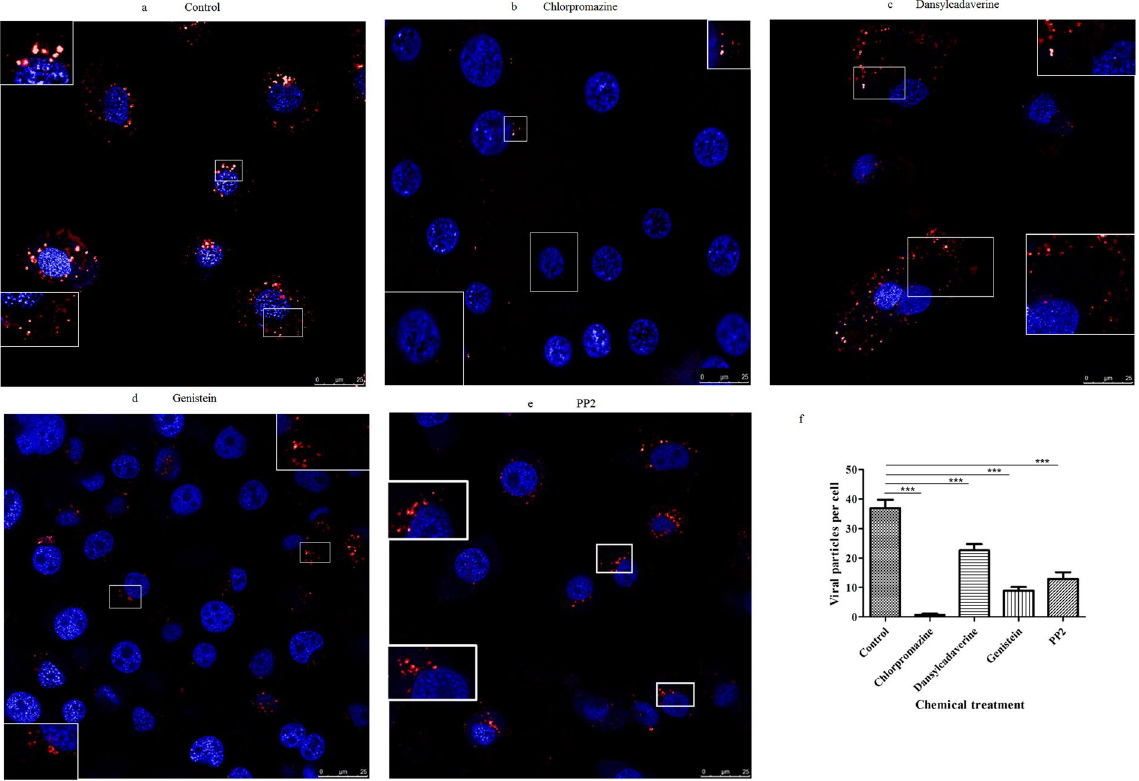
Figure 3. Confocal microscopy observations of BmCPV internalization and different distribution of BmCPV particls with different endocytic inhibitors. BmN cells were treated without inhibitors as a control ( a ); the cells were treated with chlorpromazine (2 mM) ( b ), dansylcadaverine (2 mM) ( c ), genistein (50 μ g/mL) ( d ), or PP2 (0.16 μ M) ( e ), for 30 min or 1 h, followed by inoculation with A546-labeled BmCPV virions. Thirty minutes after inoculation, images were captured by a confocal microscopy. The nucleus was stained withDAPI. ( f ) Quantification of internalized BmCPV particles in single planes of view ( n = 21 cells). Error bars indicate standard deviations. *** P <